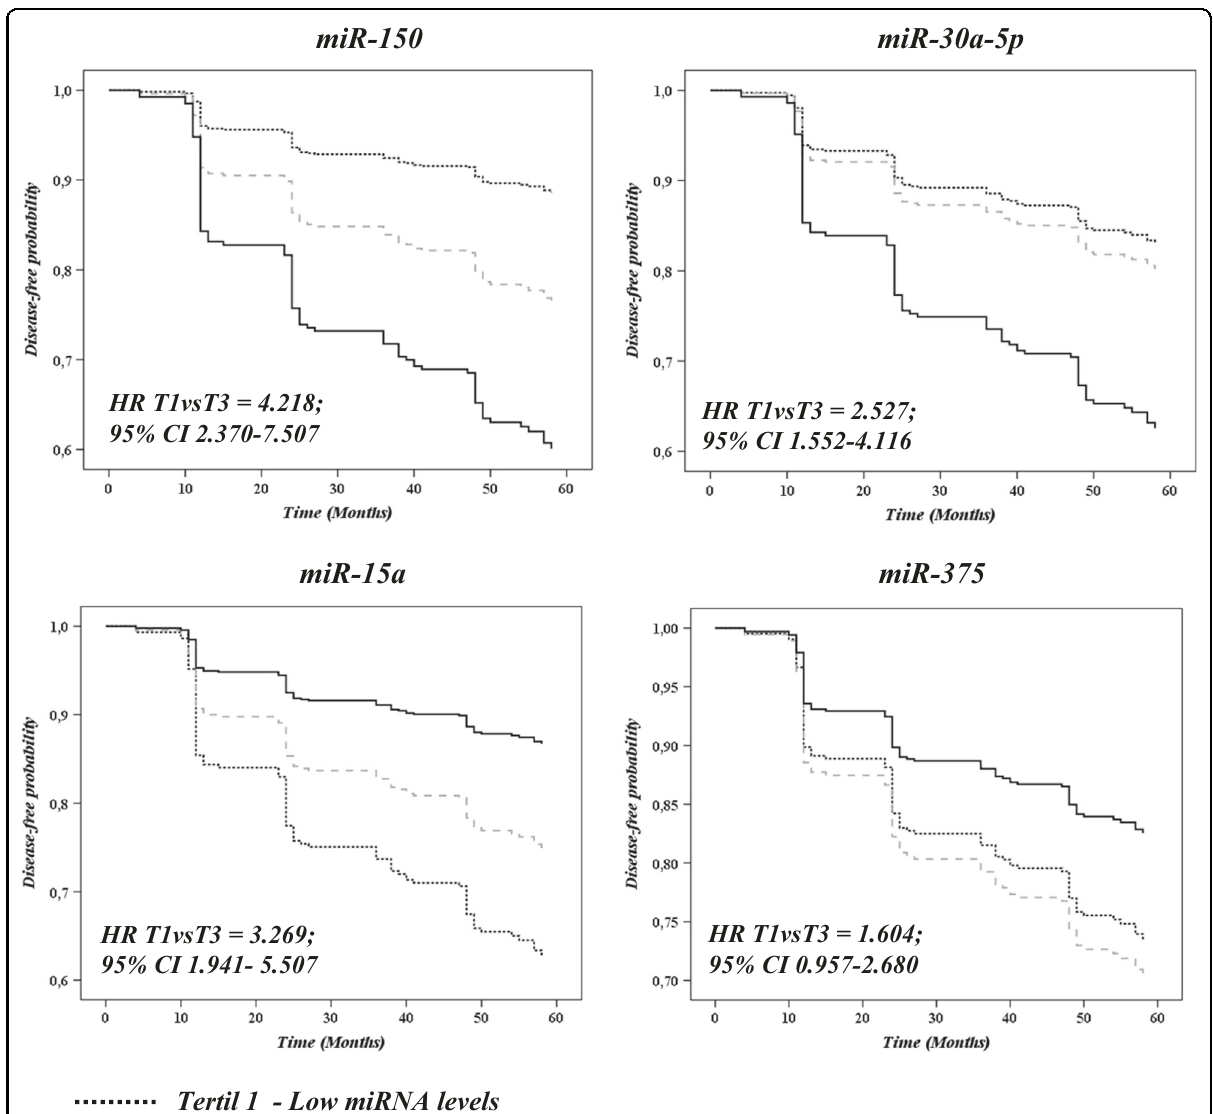
Fig. 3 Disease-free survival by COX proportional hazards regression analysis of miRNAs. Subjects were divided into low (T1), intermediate (T2) and high (T3) baseline levels of miRNAs. The dotted black line represents subjects from T1, the dotted gray line represents subjects from T2, and the continuous black line represents subjects from T3. Analyses were adjusted for age, diet, gender, body mass index, glycosylated hemoglobin, HDL, triglycerides, and waist